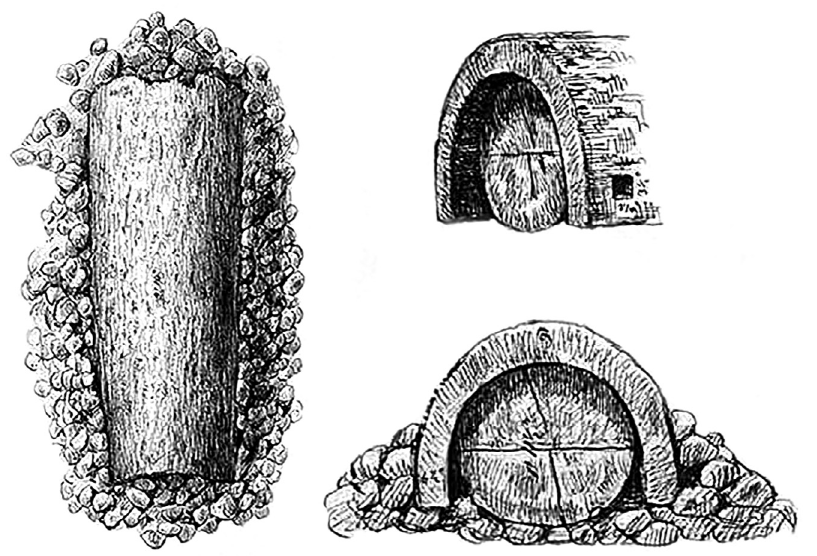
Figure 3. The Muldbjerg burial in which a de-barked oak coffin was covered by a half-hollowed tree trunk with the bark still left on the outside. Drawing by: A.P. Madsen (modified after Boye, 1896, Pl. III, and Glob, 1970, pp. 58–61).